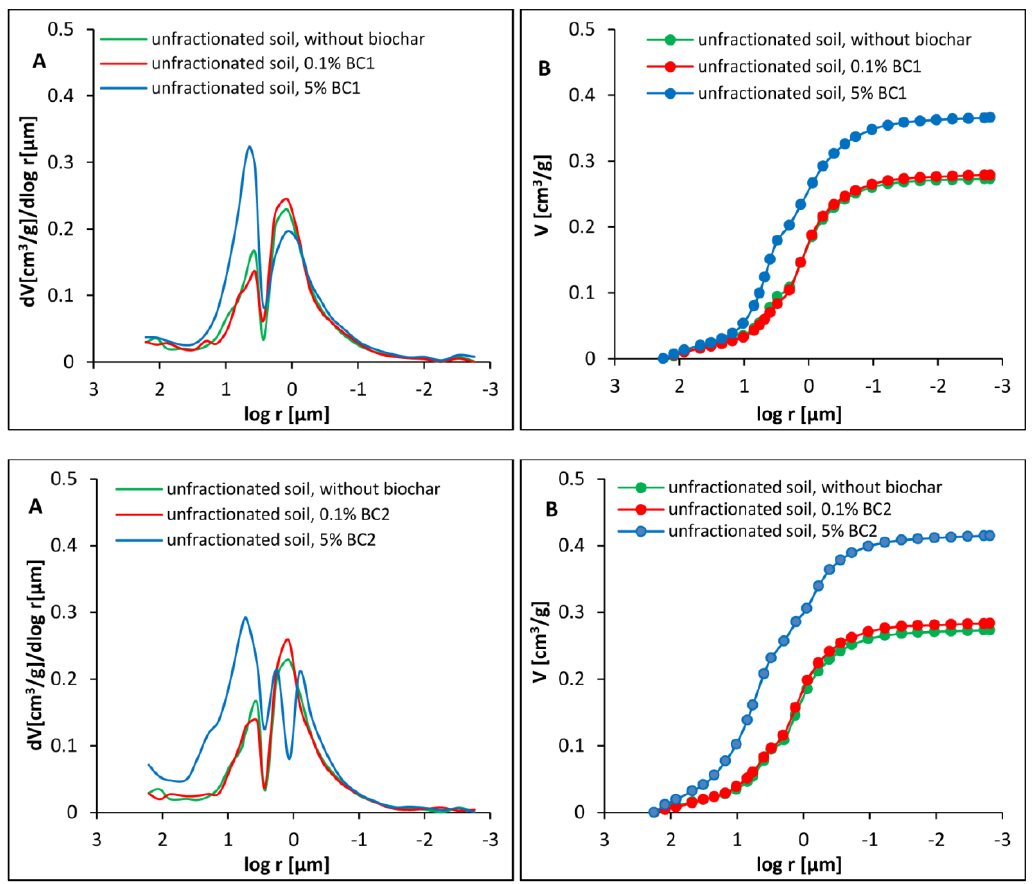
Figure 3. Differential ( A ) and cumulative ( B ) curves of pore volume vs. equivalent pore radius of cylinders remolded using unfractionated soil with and without wood waste (BC1) and sunflower husk (BC2) biochars; the curves were drawn based on the average value of three measurements.